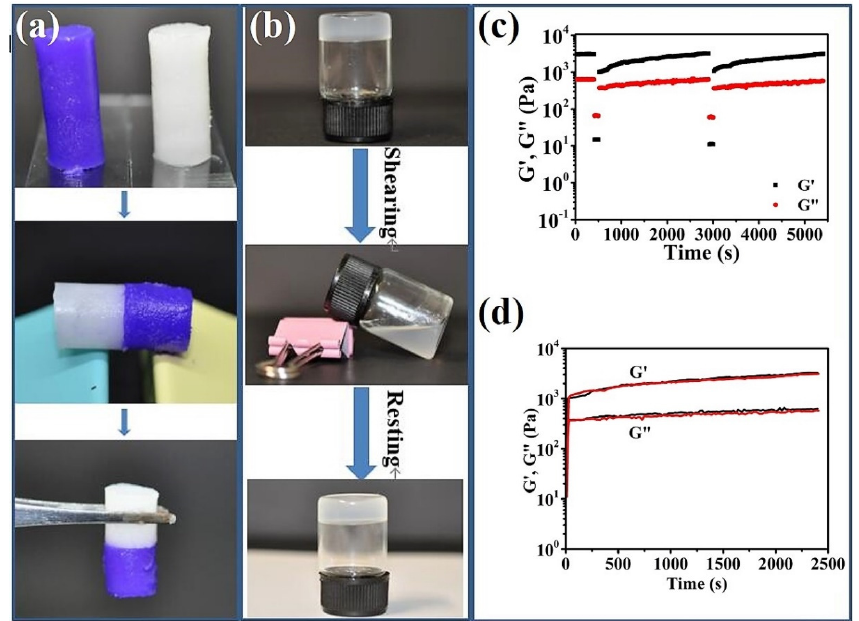
Figure 4. ( a ) Illustration of the self-healing property of the B8-BMPTFSI-NaTFSI gel (4% B8, w/v; 0.3 M NaTFSI). ( b ) Illustration of the thixotropic property of the B8-BMPTFSI-NaTFSI gel (3% B8, w/v; 0.1 M NaTFSI). ( c ) Step-strain measurements of the B8-BMPTFSI-NaTFSI gel (4% B8, w/v; 0.3 M NaTFSI) over 2 cycles (with an alternating strain of 0.05% and 100% with 1 Hz at 25 °C). ( d ) Overlaid zoom of the recovery of the B8-BMPTFSI-NaTFSI gel after each cycle. All colored gels are doped with crystal violet. Figure 5A shows the temperature dependence of the conductivities of the B8- BMPTFSI and B8-BMPTFSI-NaTFSI ionogels. Although concentrations of B8 and NaTFSI were different, the relationship between the ion conductivity of all ionogels and 1000/T exhibited good linearity, indicative of a good fit into the classical Arrhenius equation [28]. In addition, the plots described in Figure 5A were fitted by the Vogel–Tammann–Fulcher (VTF) equation: σ = σ 0 exp [ –B/ (T – T 0 )] The result suggests that the migration of the ions in B8-BMPTFSI and B8-BMPTFSI-NaT- FSI gels is similar to that of a viscous liquid [25]. The ionic conductivity of the B8- BMPTFSI-NaTFSI ionogel still achieved 10 − 3 S/m, albeit less than that of B8-BMPTFSI iono- gel.